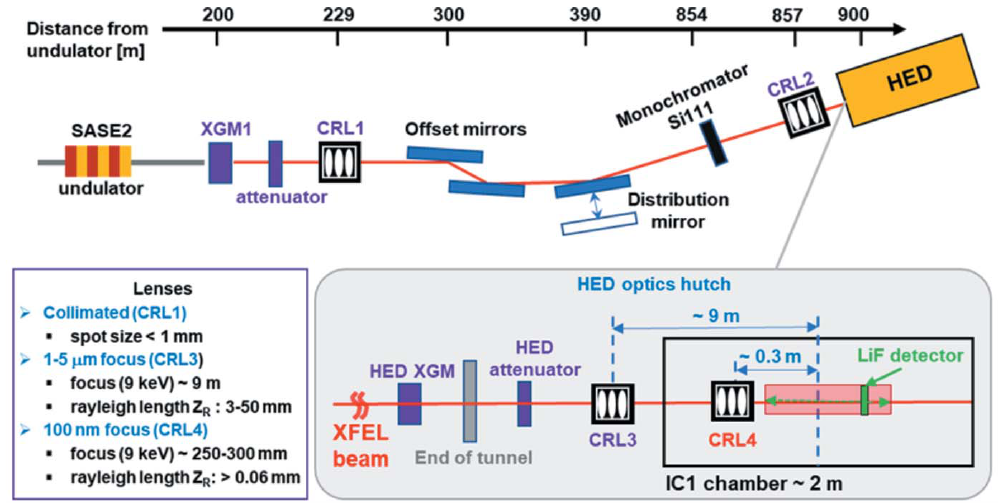
Figure 1 Schematic view of the X-ray beam transport from the SASE2 undulator to the HED experimental hutch, and parameters of CRL units 1, 3 and 4 (XGM – X-ray gas monitor for single-shot pulse energy measurements and average beam position monitoring; HED – High Energy Density instrument). Table 1 Beryllium compound refractive lenses used in the experiment on diagnostics of the X-ray focusing at the HED instrument (Zastrau et al. , 2021). Number of